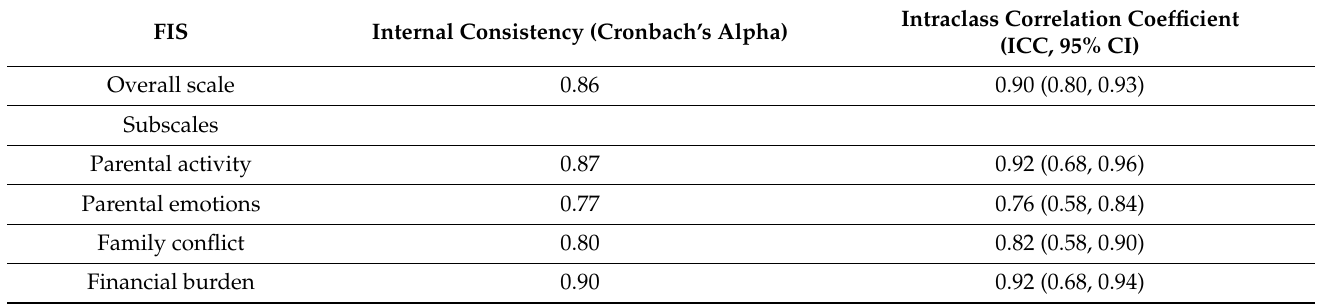
Table 3. Internal consistency and intra class correlation coefficient of the family impact